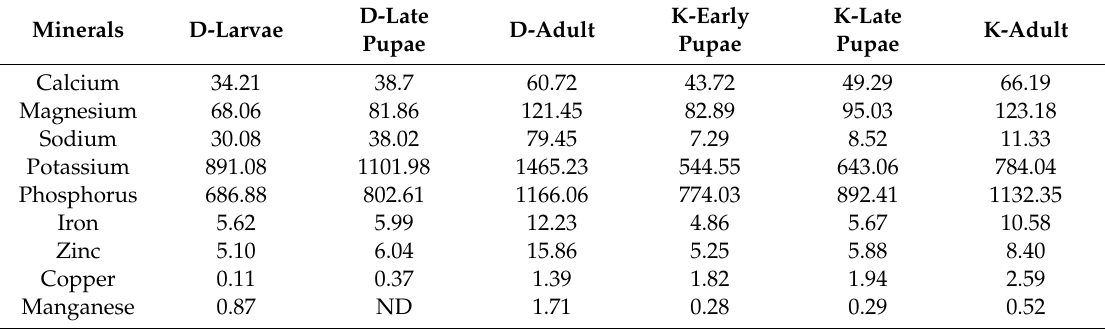
Table 3. Mineral contents (mg / 100 g dry matter basis) of di ff erent developmental stages of Italian honey bee drones from Korea (K-) and Buckfast honey bee drones from Denmark